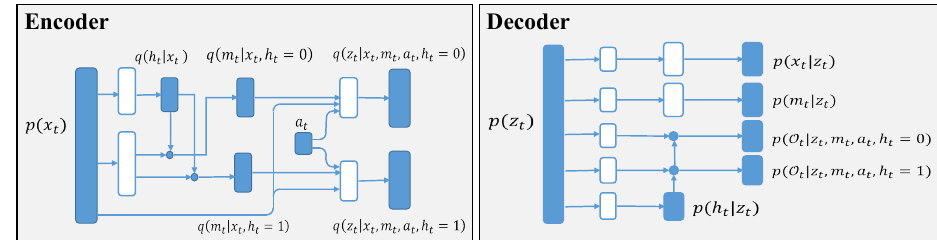
Figure 3. Architecture of the model and inference networks. White nodes are the neural network, blue nodes are samples from the distribution, and blue dots are switches according to the treatment h